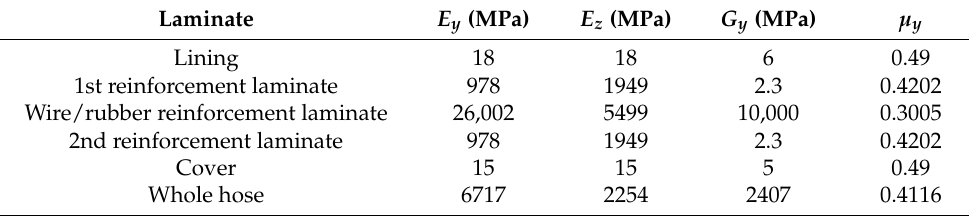
Table 3. Calculated mechanical properties of the laminates and the